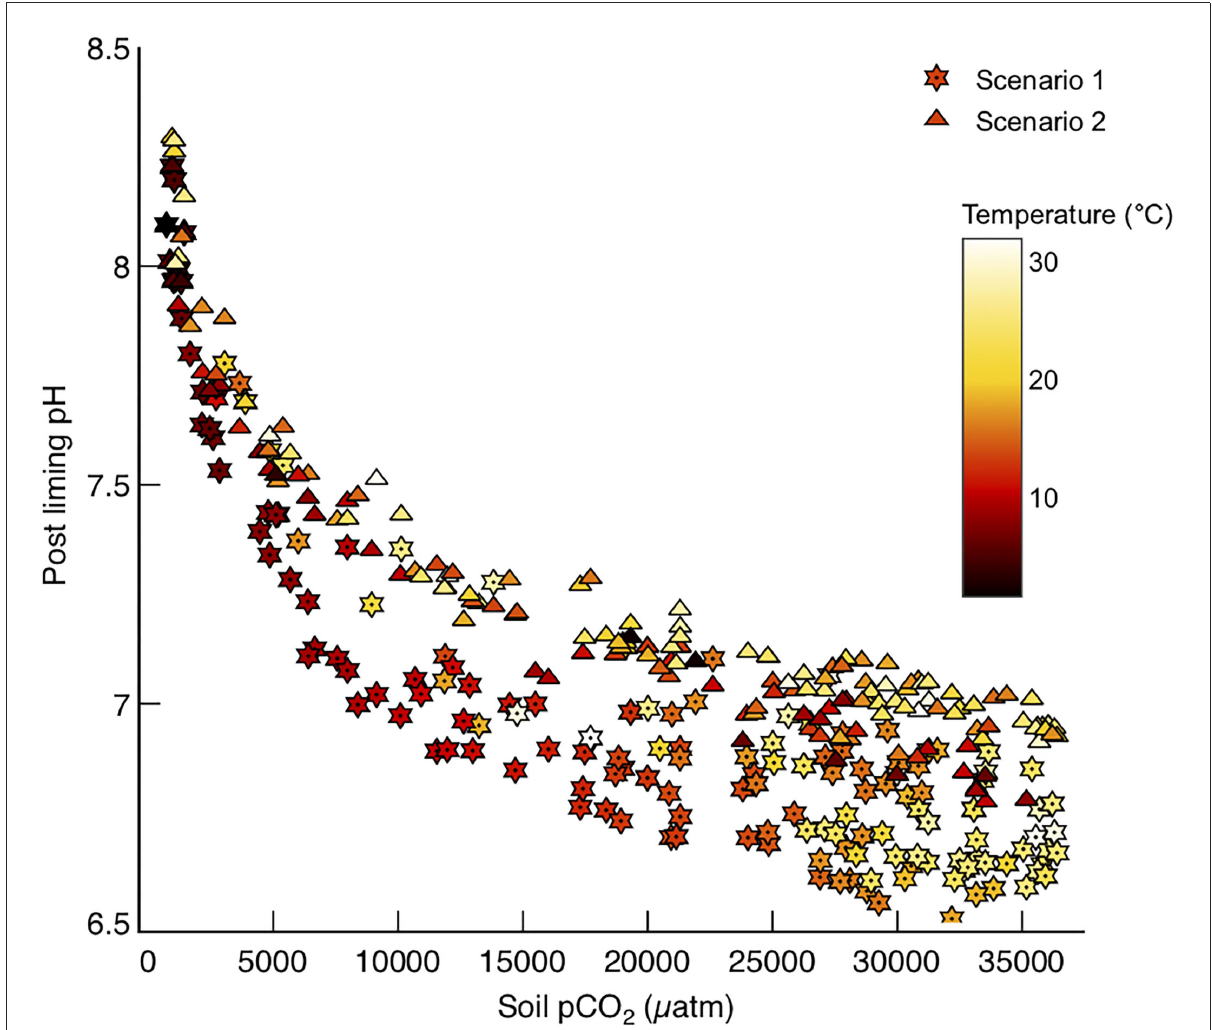
FIGURE8 pH values for soil waters in each basin, after reaction with the prescribed amount of calcite to reach the saturation states required for Model 2 (SIc = 0) and Model 3 (SIc =